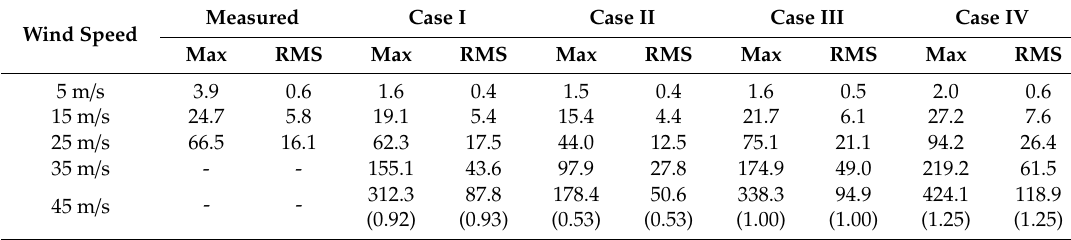
Table 8. Analytical vertical responses at the center of the mid-span (unit: